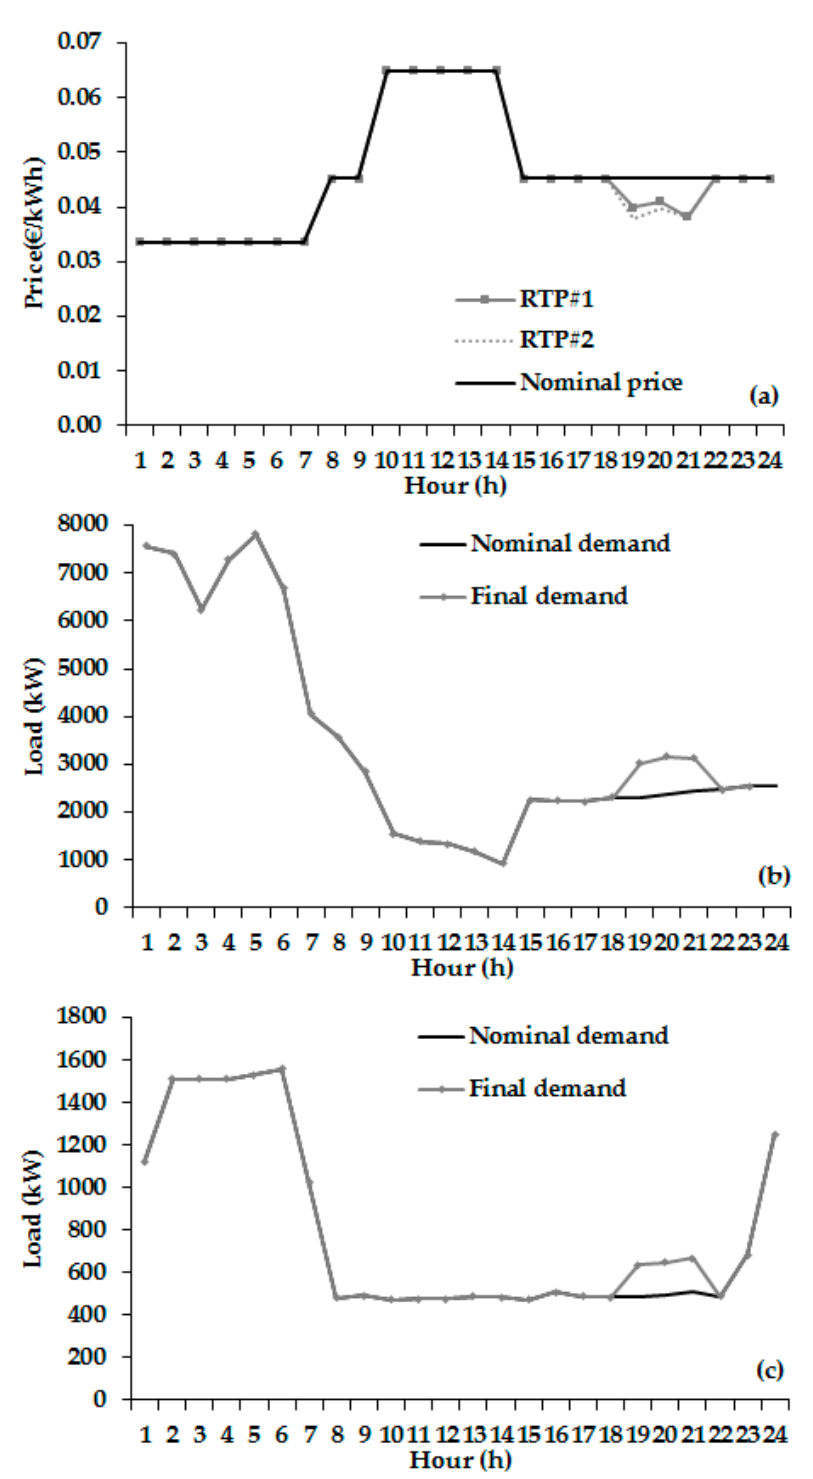
Figure 20. VF objective results with logarithmic DR model: ( a ) Nominal price and RTP; ( b ) nominal and final demand of consumer 1 and ( c ) nominal and final demand of consumer 2.